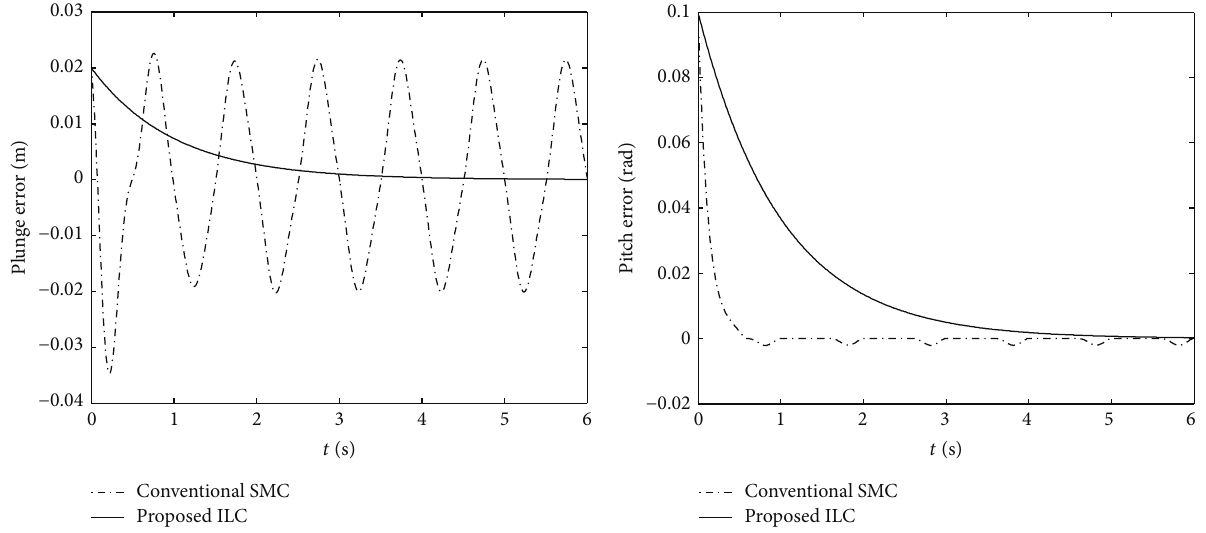
Figure 10: Comparison of the tracking error when 𝑥 ℎ,𝑑 = 0.02 sin (2𝜋𝑡) , 𝑥 𝛼,𝑑 = 0.1 sin (2𝜋𝑡)